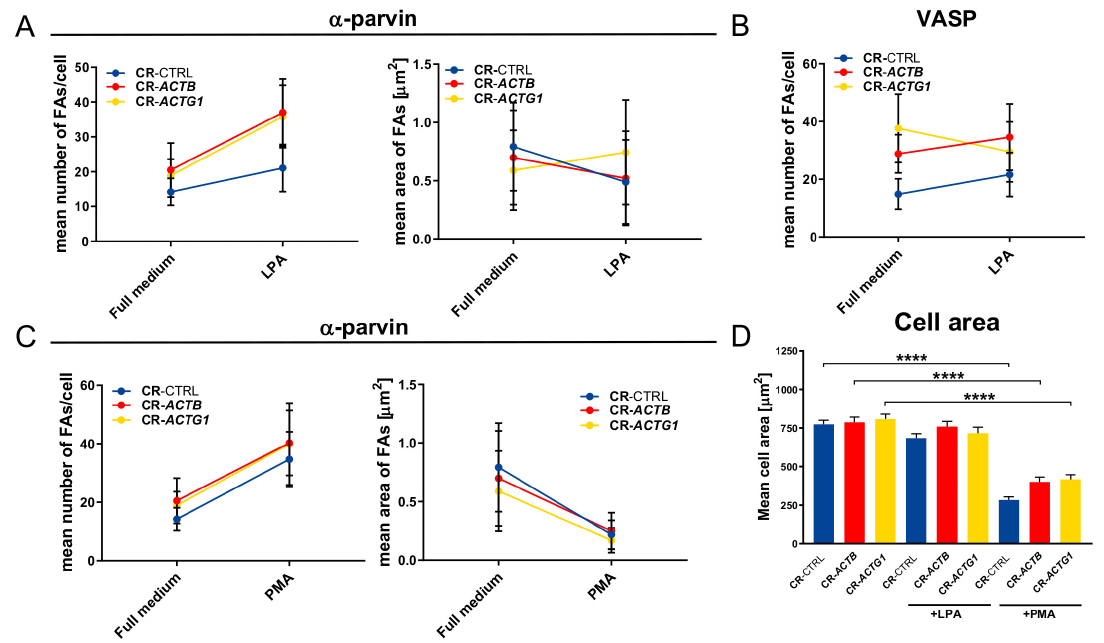
Figure 8. Trends in FAs’ formation by the studied clones and their surface area. ( A – C ) Slope graphs presenting trends upon LPA or PMA stimulation in number and surface area of focal adhesion detected either by staining with α -parvin or VASP-detecting antibodies ( n = 30). ( D ) Clones’ cells surface area upon LPA and PMA stimulation was calculated and presented as a bar chart ( n = 30). Results are expressed as the mean ± SD ( A – C ) or ± SEM ( D ), p ≤ 0.0001 (****).